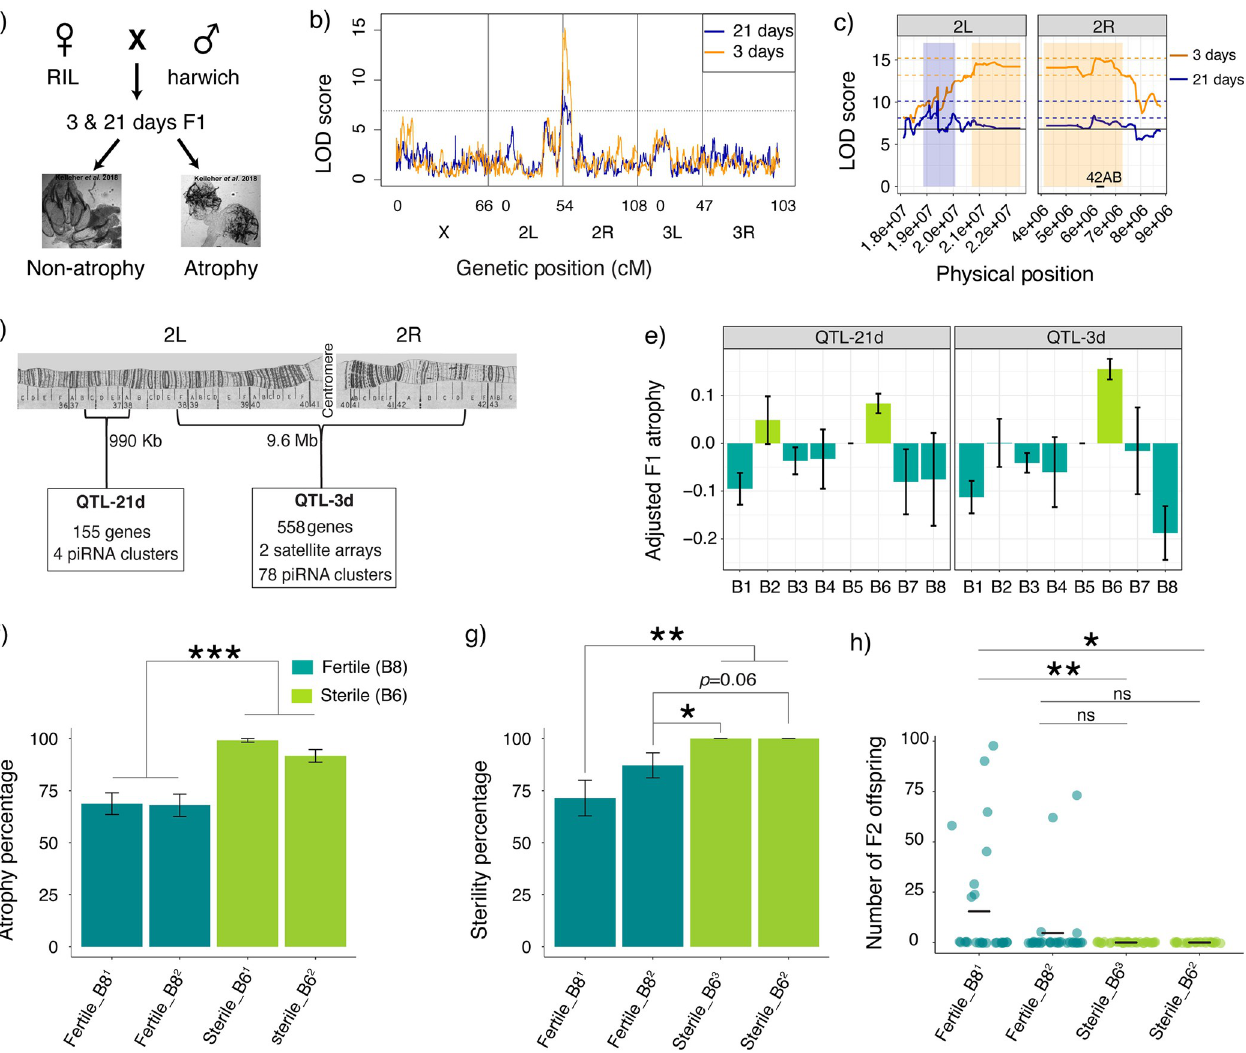
Fig 1. QTL mapping of variation in P -element induced ovarian atrophy. a) Crossing scheme to phenotype the variation in F1 ovarian atrophy among RIL offspring. Representative images of atrophied and non-atrophied ovaries are from Kelleher et al. [14] b) The log of odds (LOD) plot for QTL mapping of ovarian atrophy using 3 day-old (gold) and 21 day-old (blue) F1 females. The dotted line is the LOD threshold and x-axis represents the chromosomal positions. c) Zoomed-in figure of QTL mapping from 3 days (gold) and 21 days (blue). The colored boxes show the genomic interval that likely contains the causative genetic variant of each QTL, based on a Δ 2LOD drop from the peak position [26]. The pairs of dotted lines indicate the peak Δ 2LOD scores that determines the interval. The solid horizontal line is the LOD significance threshold based on 1,000 permutations of the phenotype data. d) Cytological map depicting the interval of the two QTL peaks [27,28]. e) Residual F1 atrophy (y-axis) associated with each of the eight founder alleles (x-axis) at the QTL peaks after accounting for random effects. All the QTL peaks show 2 phenotypic classes: sterile (light green) and fertile (dark green). (f-g) Percentage of (f) ovarian atrophy and (g) sterility among dysgenic female offspring from crosses between Harwich males and isogenic females carrying sterile (B6) and fertile (B8) alleles. Proportions were compared between samples using χ 2 tests of independence. h) Number of F2 offspring produced by individual dysgenic F1 females from crosses between Harwich males and isogenic fertile and sterile females. The horizontal line indicates the mean, which was compared between samples using permutation tests. Superscripts1,2 and 3 in ( f-h ) denote isogenic lines that were independently generated, these sometimes differ between experiments because sterile_B61 became contaminated and was replaced with sterile_B63. Error bars in e, f and g represent the standard error. The data used to generate plot in panels b , c , and e are provided in S3 and S4 Tables and that used for plot in panels f , g and h are provided in S17 and S18 Tables respectively. � denotes P < 0.05, �� denotes P < 0.01, ��� denotes P <